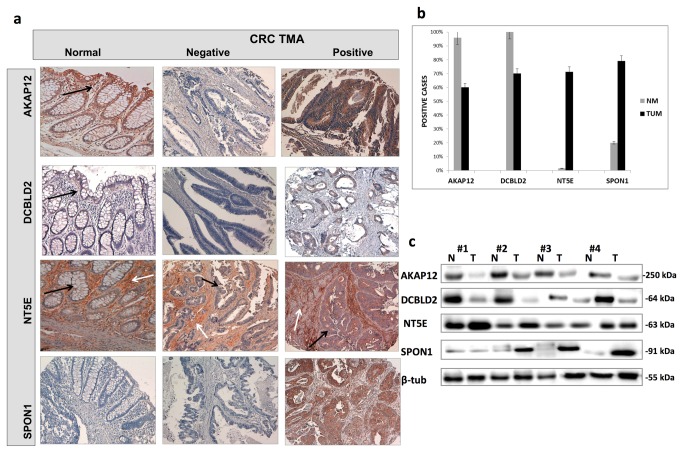
TMAs and western blot validation analysis of AKAP12, DCBLD2, NT5E and SPON1.
a. “Columns from left to right” indicate immunostaining pattern in normal colonic samples and CRC cores negative and positive for each marker AKAP12, DCBLD2, NT5E, SPON1. Black arrows indicate immunohistochemical staining pattern in normal or malignant colonic cells. White arrows indicate the immunostaining distribution in the stromal compartment (endothelial, regulatory T-cells and macrophages) characteristic of NT5E expression pattern. Magnification 10X; b. Number of positive cases detected on TMA validation series comprising tumor specimens (TUM) and a subgroup of matched normal colonic mucosa (NM). Error bars indicate the standard deviation from the mean (p < 0.05); c. Four representative frozen CRC specimens (T) and matched normal mucosa (N) were identified in the same cohort of patients and analyzed by immunoblot. Molecular weight markers are indicated in kilodaltons. β-tubulin was used as loading control to normalize band intensities.